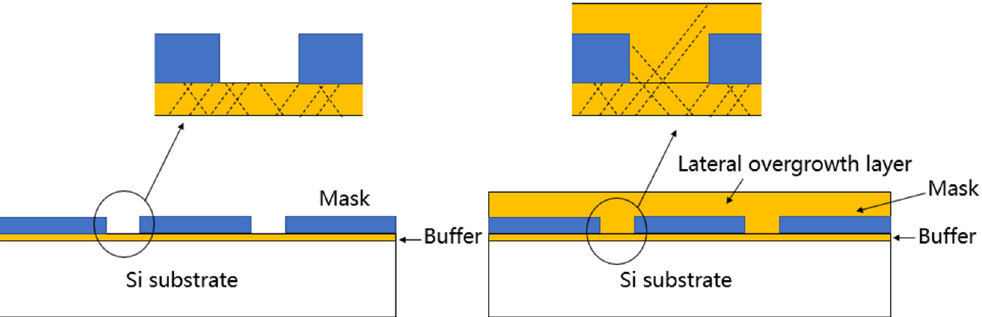
Figure 10. Principle of ART and epitaxial lateral overgrowth (ELO). The circle is a partially enlarged view of the dislocation propagation. The dislocations, marked as dotted lines, only propagate to the lateral overgrowth layer through openings in the patterned mask.